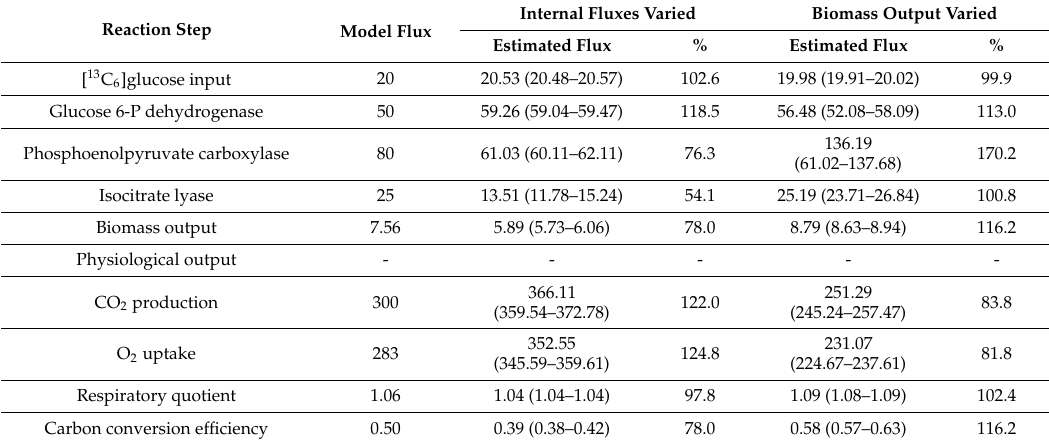
Table 1. Accuracy of flux estimates in heterogeneous networks of primary carbon metabolism. Flux maps were determined from mass isotopomer distributions obtained by combining data from metabolic networks yielding identical mean flux distributions. The networks used to generate the mass isotopomer data differed in internal fluxes alone (models 2 + 3; Table S4), or in combination with variation in biomass output (models 4 + 5; Table S4). Values are best-fit flux estimates with the 95% confidence limits shown in parentheses; flux estimates are also expressed relative to the predicted flux obtained from the mean of the networks used to derive the combined mass isotopomer data. Similar analyses of networks in which biomass output varied in both amount and composition (models 6 + 7; Table S4) are presented in Table